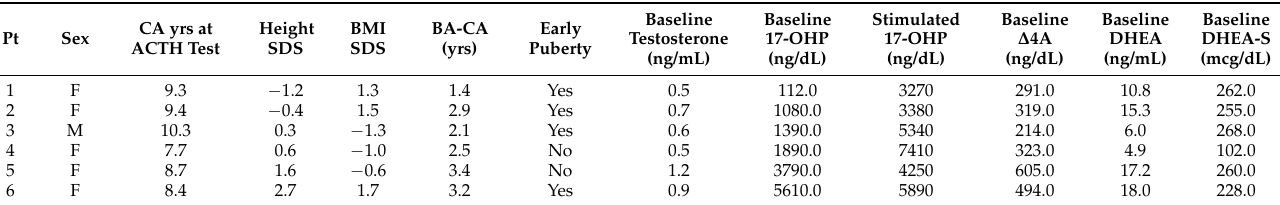
Table 4. Clinical features and androgen levels in patients with NC21OHD.